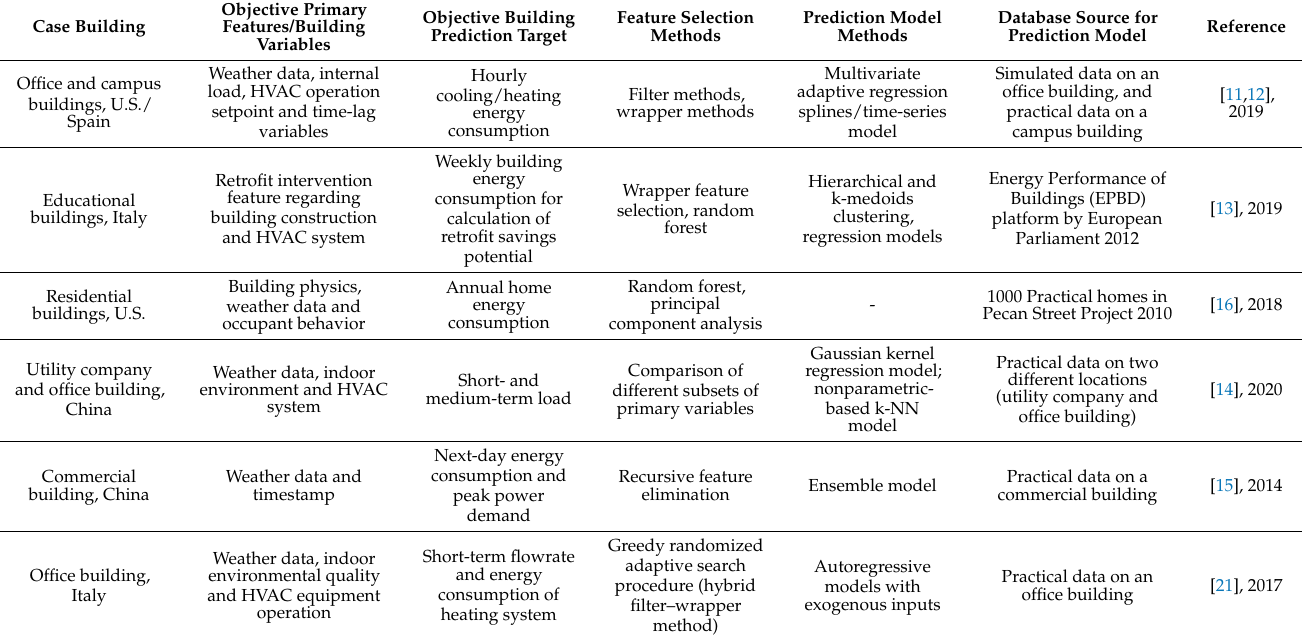
Table 1. Summary of building energy model studies focused on feature selection and